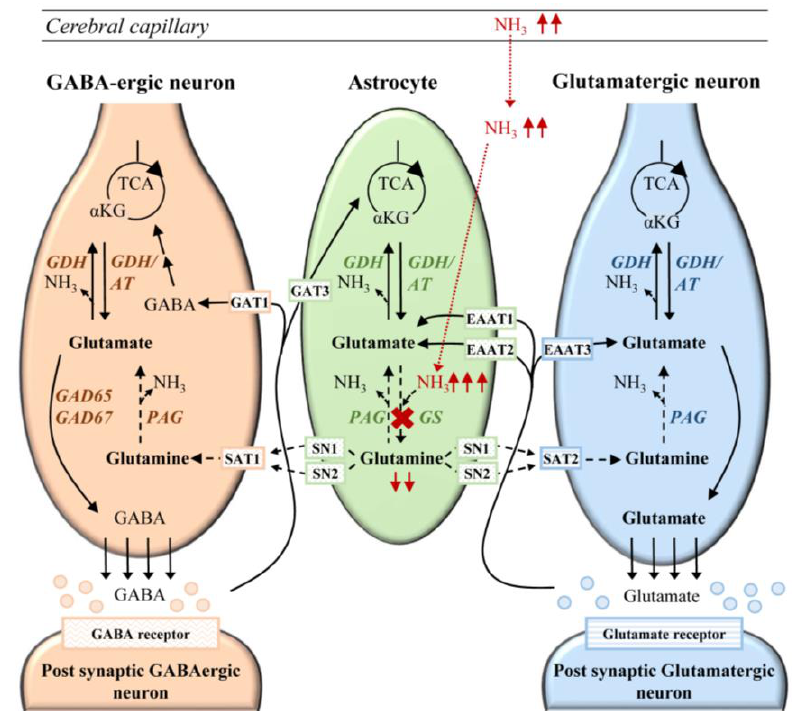
Figure 3. Schematic representation of the hypothetical pathophysiology of GS deficiency in the brain. In GS deficiency, ammonia is elevated in the body circulation and diffuses via the blood–brain-barrier into the brain (indicated by a red dotted line). The defect in the GS reaction results in decreased ammonia detoxification, an excess of ammonia (red upward arrows), and lack of glutamine (red downward arrows), leading to a failure to replenish the glutamine-glutamate-GABA cycle. Intermediates of the TCA cycle: αKG: α-ketoglutarate; Enzymes: GDH, glutamate dehydrogenase; AT, aminotransferases; GS, glutamine synthetase; GAD65, glutamate decarboxylase 65; GAD67, glutamate decarboxylase 67; PAG, phosphate-activated glutaminase; Transporters: GAT1, GABA transporter 1; GAT3, GABA transporter 3; SAT1, system A transporter 1; SAT2, system A transporter 2; SN1, system N transporter 1; EAAT1, excitatory amino acid transporter 1; EAAT2, excitatory amino acid transporter 2; EAAT3, excitatory amino acid transporter 3; Neurotransmitter: GABA, gamma-aminobutyric acid.